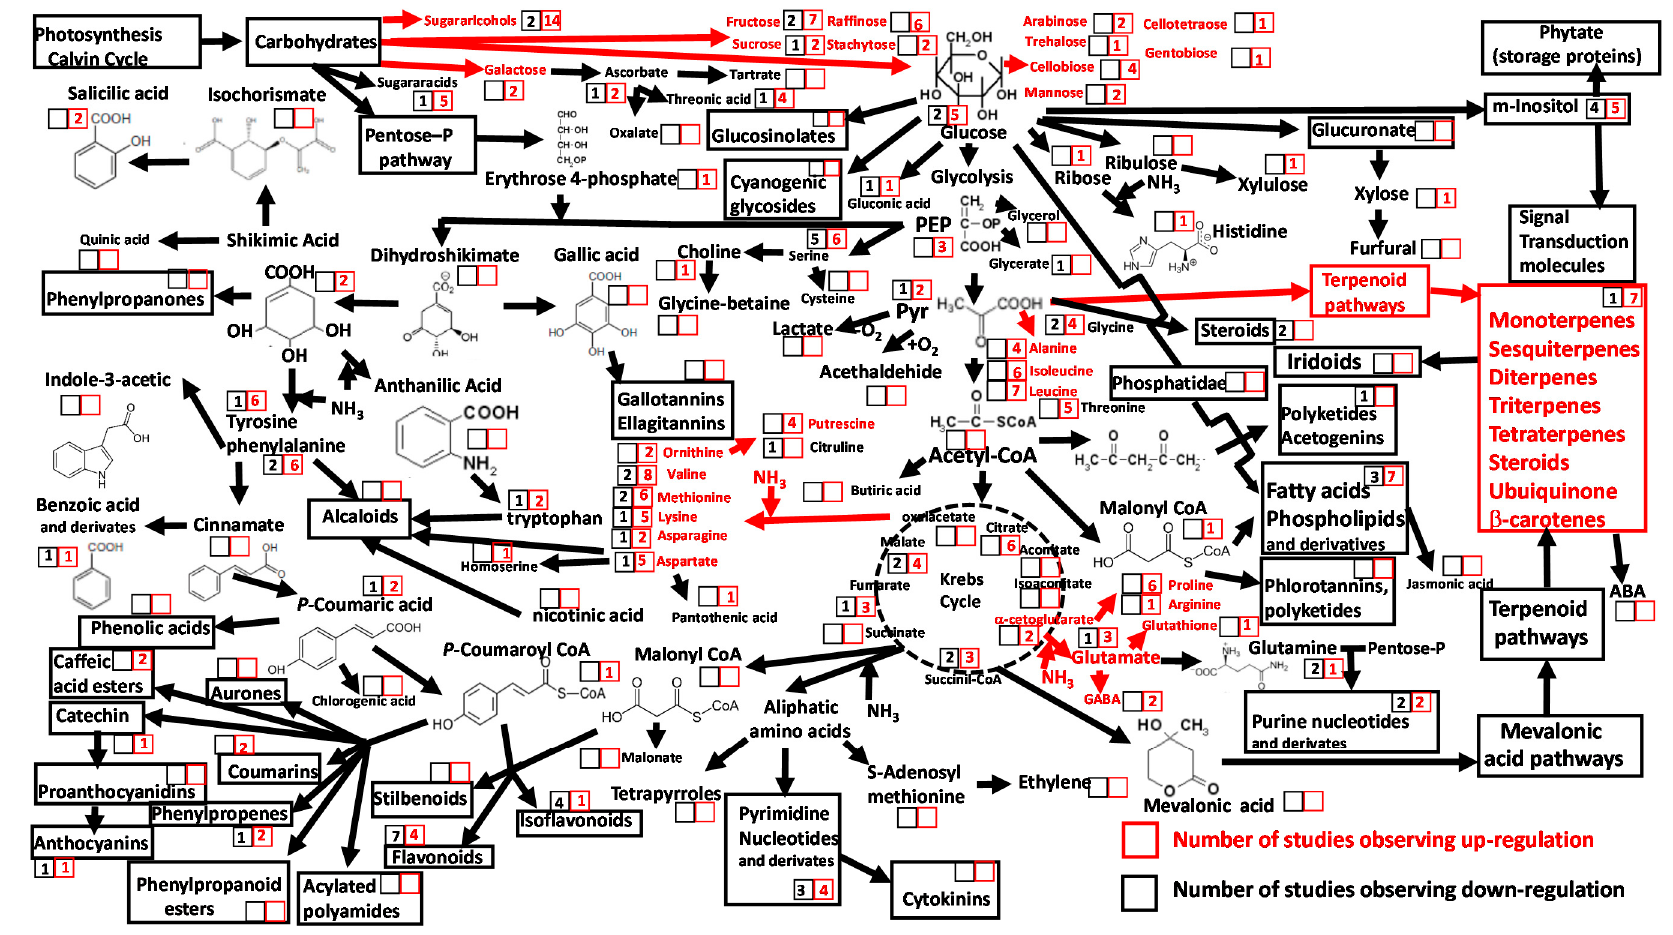
Figure 2. Shifts in principal plant metabolites and metabolic pathways in response to heat stress reported in 22 ecometabolomic studies. The numbers within the squares are the numbers of reports describing changes in photosynthetic tissue metabolite concentration and / or pathway activity under heat stress. Red numbers within red squares indicate significant increases; black numbers within black squares indicate significant decreases. Red arrows indicate upregulation of the metabolic pathway.